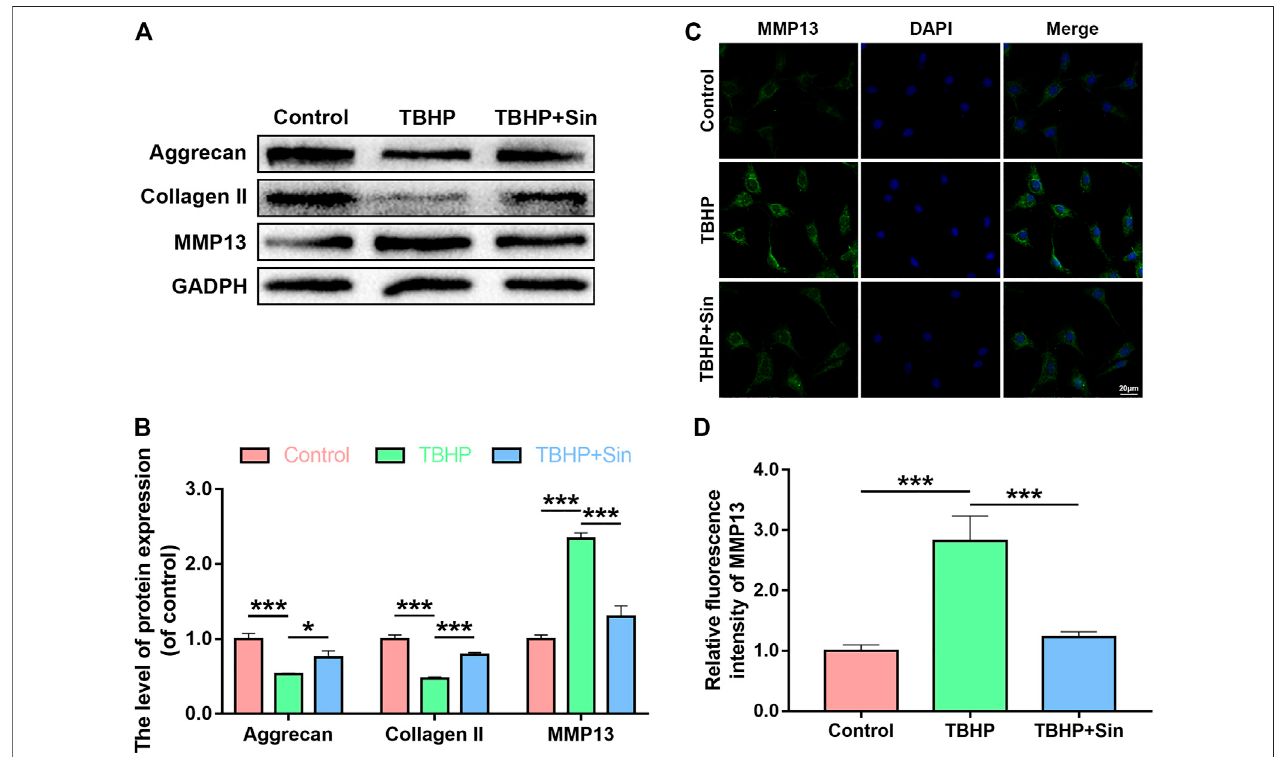
FIGURE 3 | Sin protects TBHP-treated chondrocytes from ECM degradation. (A, B) The results of western blotting show the levels of aggrecan, collagen II and MMP13 proteins in thechondrocytes treated withor without 40 μ MSin for 24 h and 30 μ M TBHP for 24 h. (C, D) Theresults ofimmuno fl uorescence show theintensity of MMP13 in the chondrocytes as treated above (Scale bar: 20 μ m). The data are presented as the means ± SD ( n (cid:1) 3); * p < 0.05, ** p < 0.01, and *** p < 0.001.